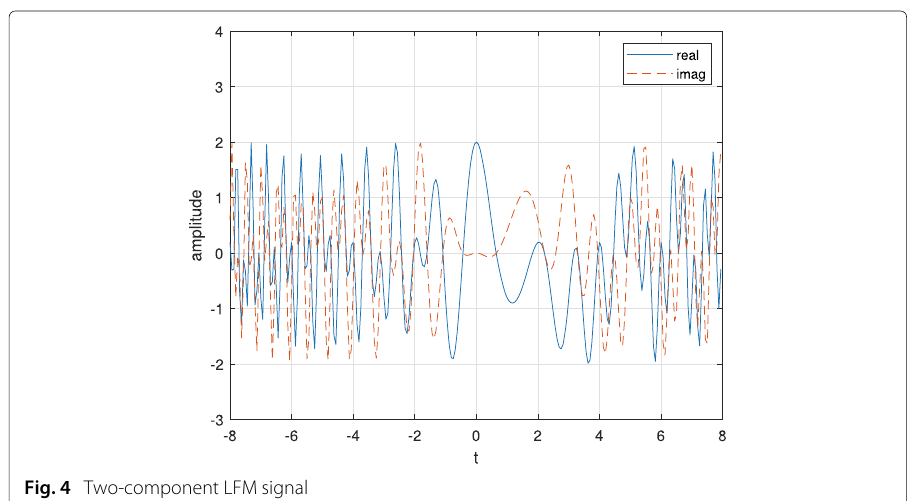
Fig. 4 Two-component LFM signal